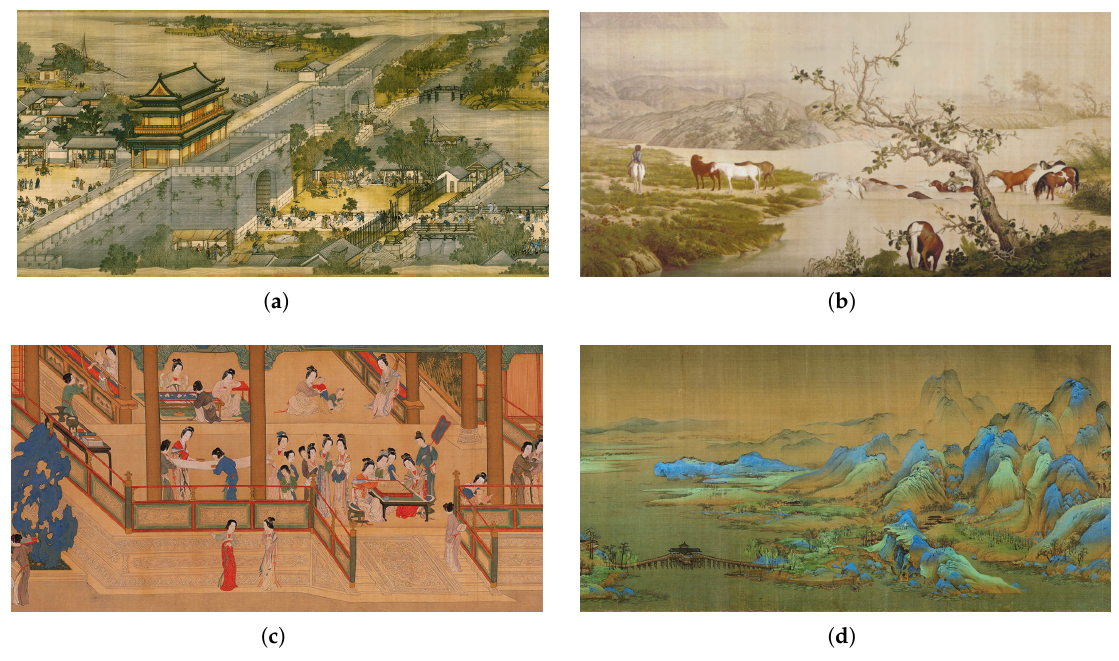
Figure 1. ( a ) Part of Along the River during the Qingming Festival (original size: 38,414 × 1800); ( b ) part of One Hundred Horses (original size: 16,560 × 2022); ( c ) part of Spring Morning in the Han Palace (original size: 102,955 × 5228); ( d ) part of A Thousand Li of Rivers and Mountains (original size: 150,000 ×